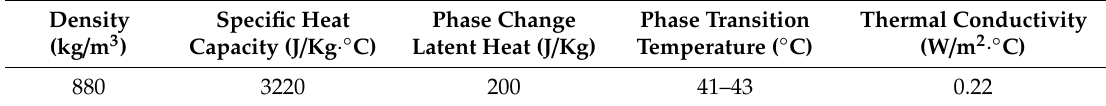
Table 4. Phase change para ffi n parameter